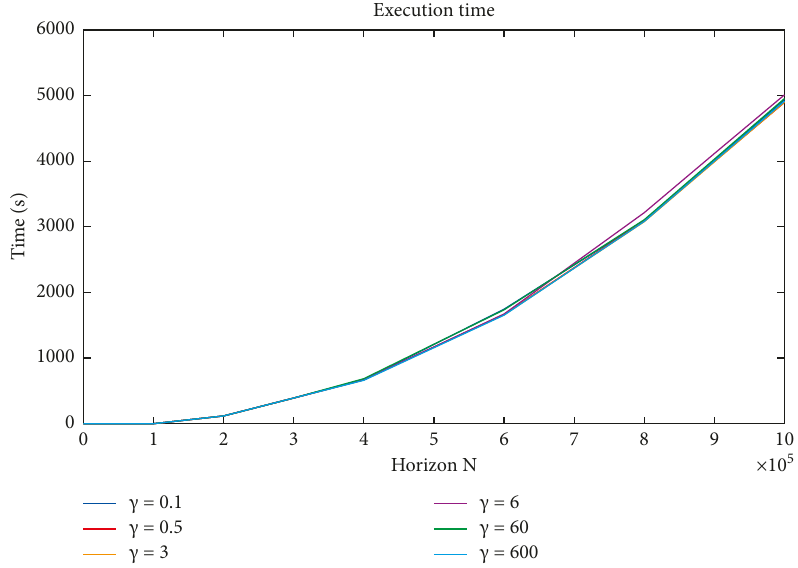
Figure 8: Execution time when the initial capital is $ 1 Table 6: Execution time when the initial capital is $ 1